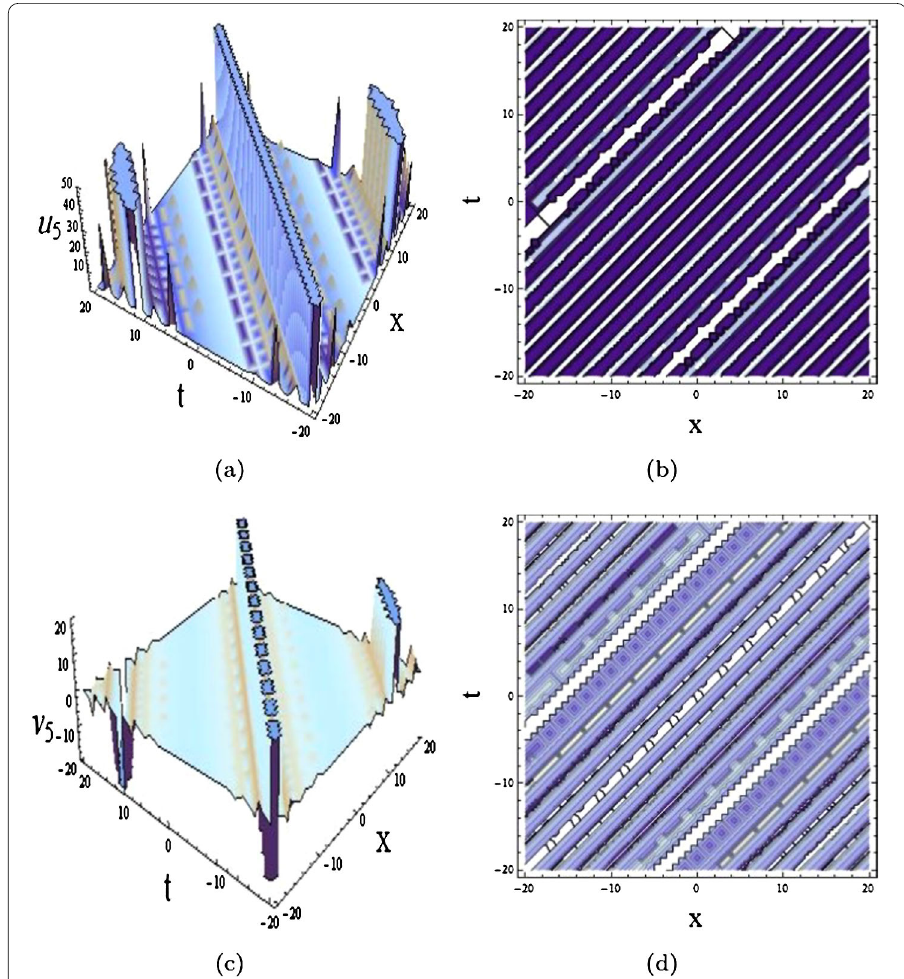
Figure 3 Plot of explicit solution (36) with a = b = k = q = 1. (a) Perspective view of the solution u 5 ( x , t ). (b) Overhead view of the solution u 5 ( x , t ). (c) Perspective view of the solution v 5 ( x , t ). (d) Overhead view of the solution v 5 ( x , t